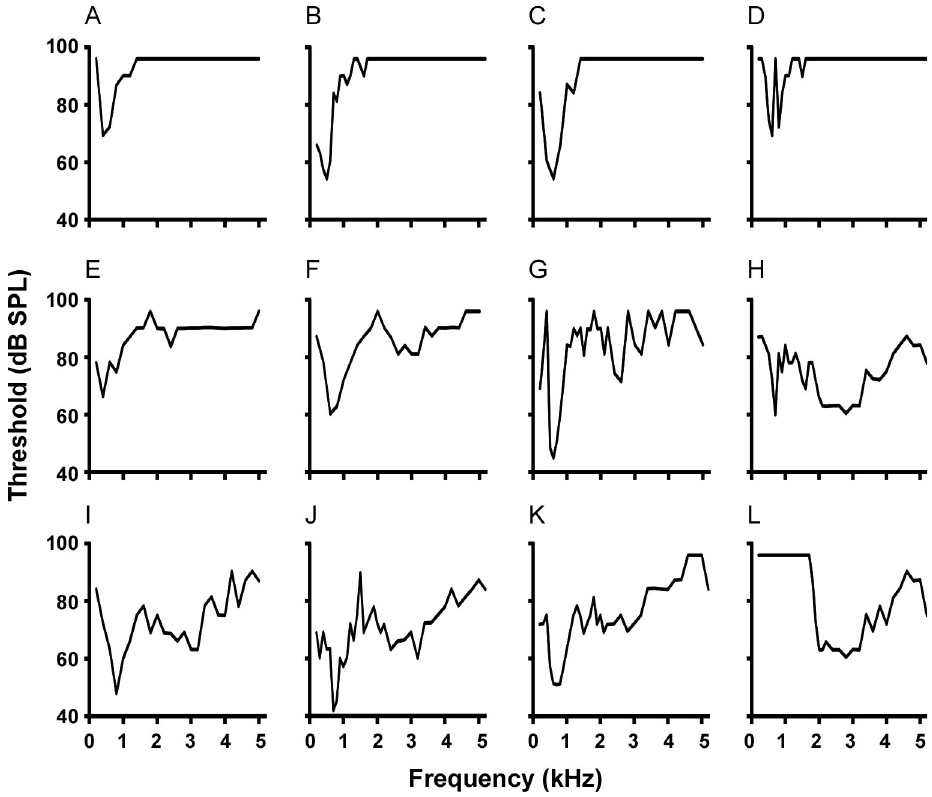
Fig 3. Example tuning curves showing cells with best frequencies ranging from low to high frequencies in panels A-L, respectively. (A-D) Cells exhibiting low frequency tuning only ( < 1.2 kHz), potentially receiving input from the amphibian papilla. (E-K) Cells exhibiting ‘W’ shaped tuning, potentially corresponding to input from both the amphibian and basilar papillae. (L) Example of high frequency ( > 1.2 kHz), potentially receiving input from the basilar papilla, only. This cell (L) contributed to the analysis of frequency tuning, but did not respond to the whine.